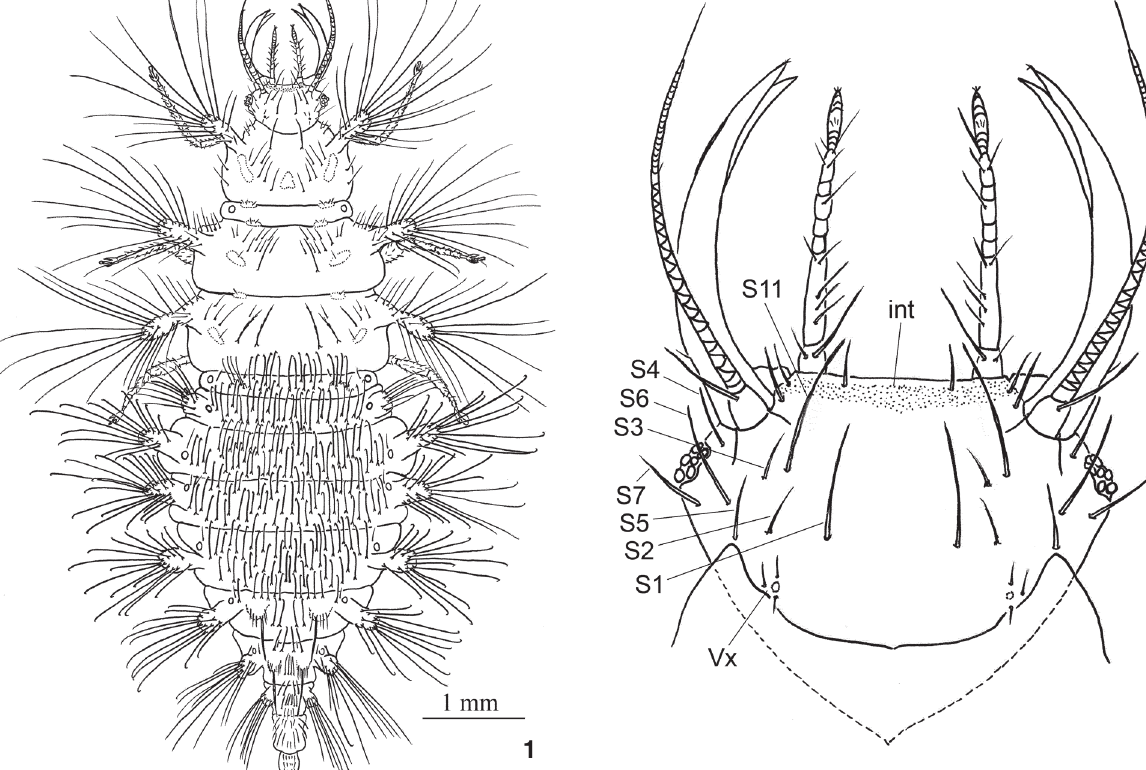
Figuras 1-2. Larva de terceiro instar de C. caligata : (1) vista dorsal; (2) cabeça, vista dorsal. (int) Mancha intermandibular, (Sx) cerda primária, (Vx) três pequenas cerdas posteriores ao redor de um